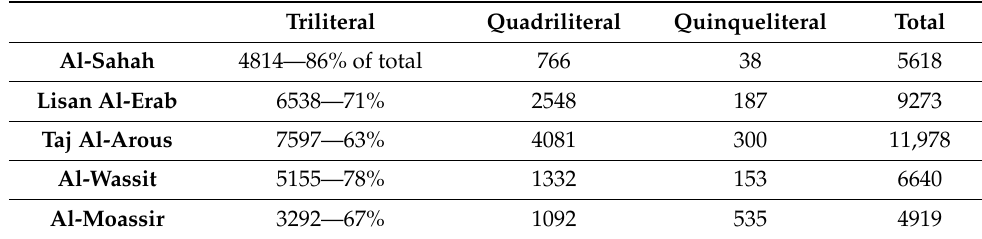
Table 1. Lexicon statistics.